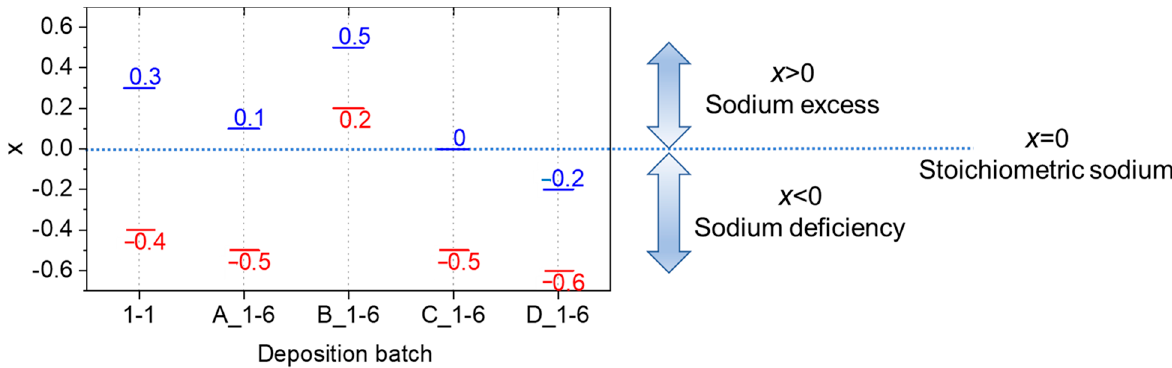
Figure 5. Maximum (in blue) and minimum (in red) values of x for each deposition batch.